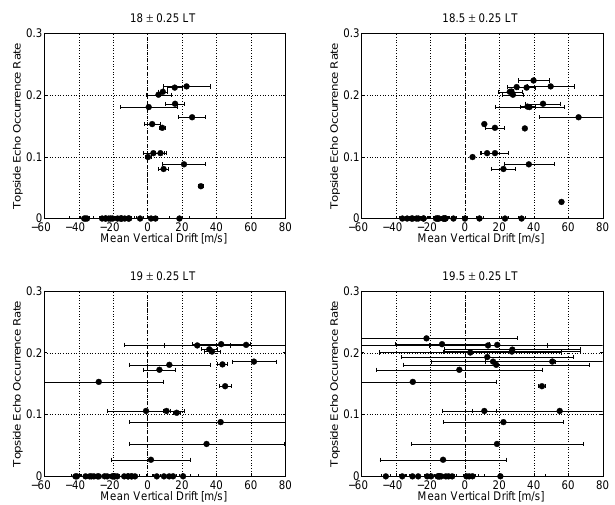
Figure 5. Scatter plots of the mean vertical drifts measured by the C/NOFS IVM near the São Luis site (at four different local times) versus the topside ( > 400km altitude) echo occurrence rate dur- ing pre-midnight hours (20:00–24:00LT) as measured by the São Luis radar on the same evening. The topside echo occurrence rate is defined as the number of height/LT bins in the RTI map between 20:00–24:00LT and above 400km altitude with SNR > 0dB echoes divided by the total number of